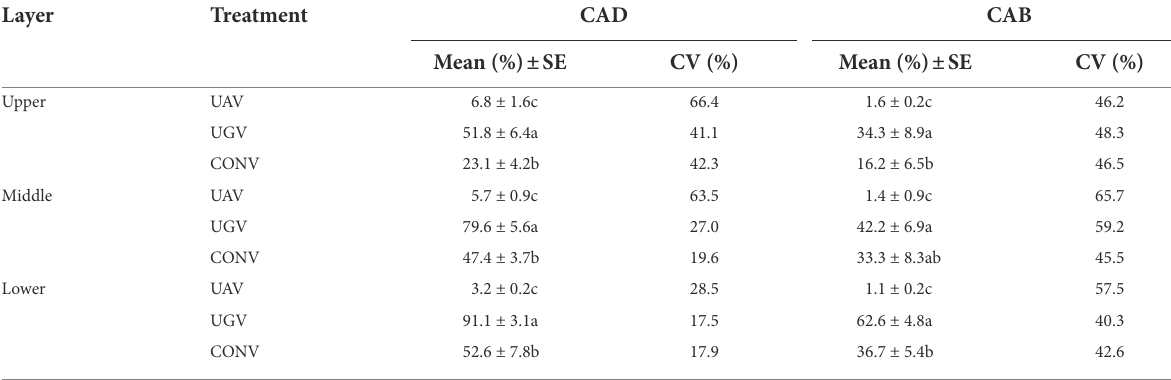
TABLE 2 Comparison of deposit coverage on the adaxial side (CAD) and abaxial side (CAB) of the leaf between different layers and spraying techniques. Layer